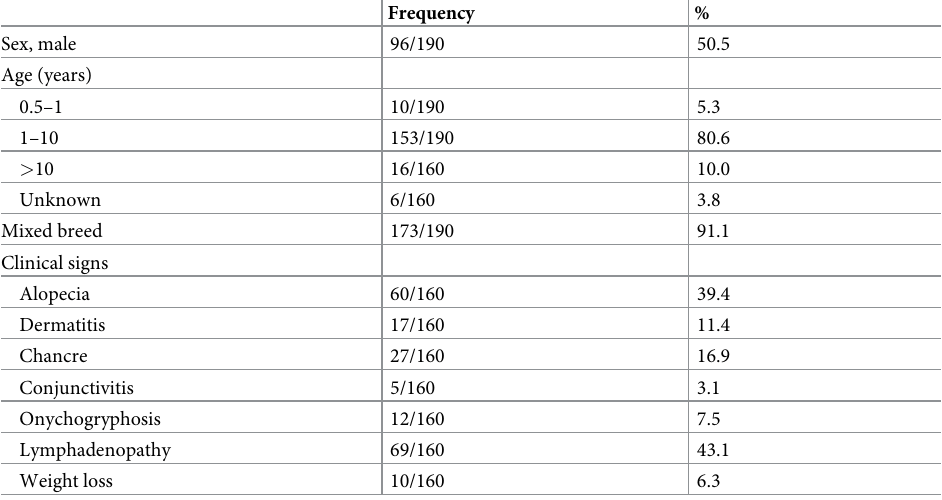
Table 1. Demographic and clinical data for 2018 (160 dogs), and where available additionally for 2019 (30 dogs). Frequency % Sex,